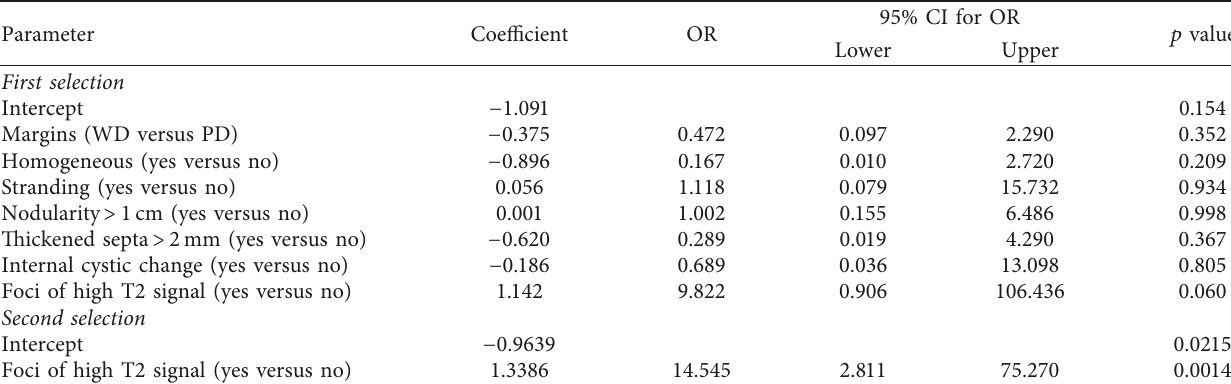
Table 3: Imaging parameter in stepwise model selection. Significance coefficient of 0.1 was required to remain in the